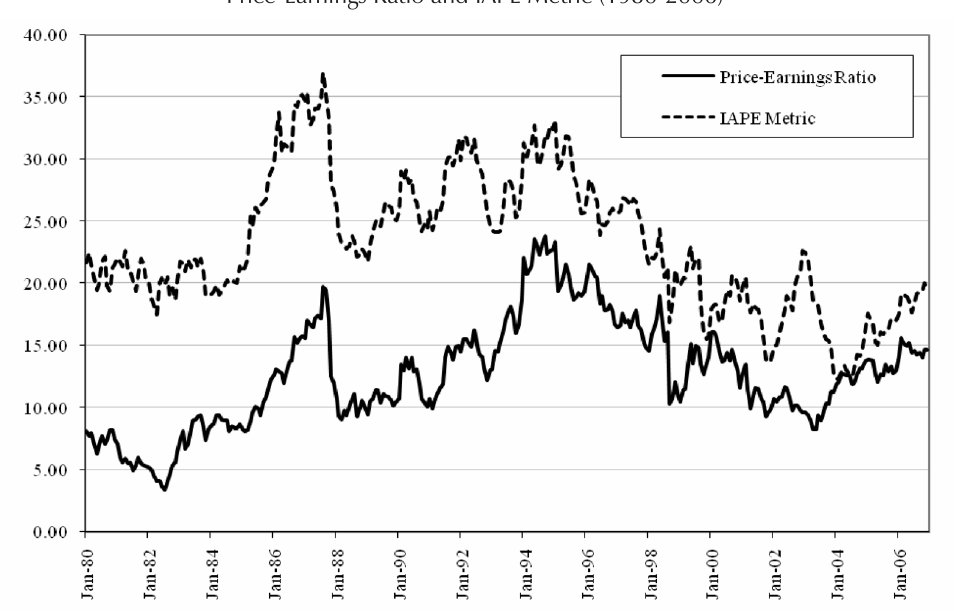
Price-Earnings Ratio and IAPE Metric